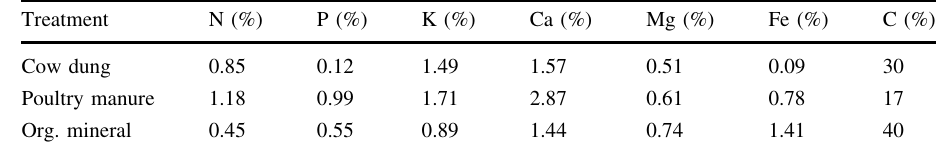
Table 2 Chemical properties of the different types of organic materials